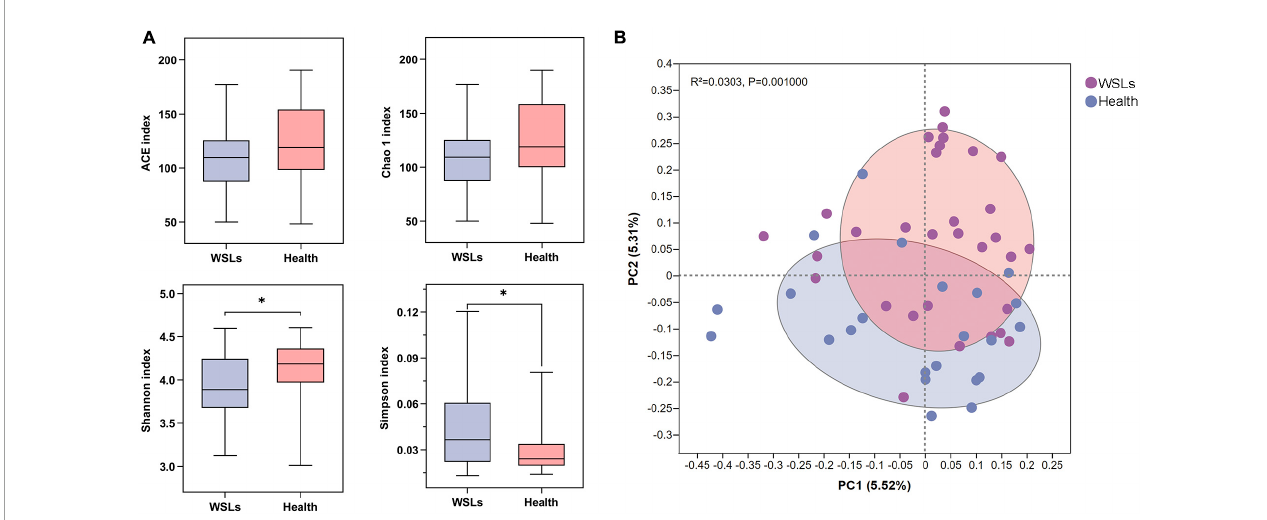
FIGURE1 Comparisons of microbial diversities between WSLs and health group. (A) Alpha diversity was evaluated by indices of ACE, Chao1, Shannon, and Simpson. Simpson and Shannon indices showed significantly higher diversity in the microbial community of health group ( ∗ P < 0.05). (B) Beta diversity was calculated via the comparison of principal coordinates analysis (PCoA) of both groups. Each dot represents one sample. The communities in WSLs group tended to cluster apart from the communities in health group ( P <